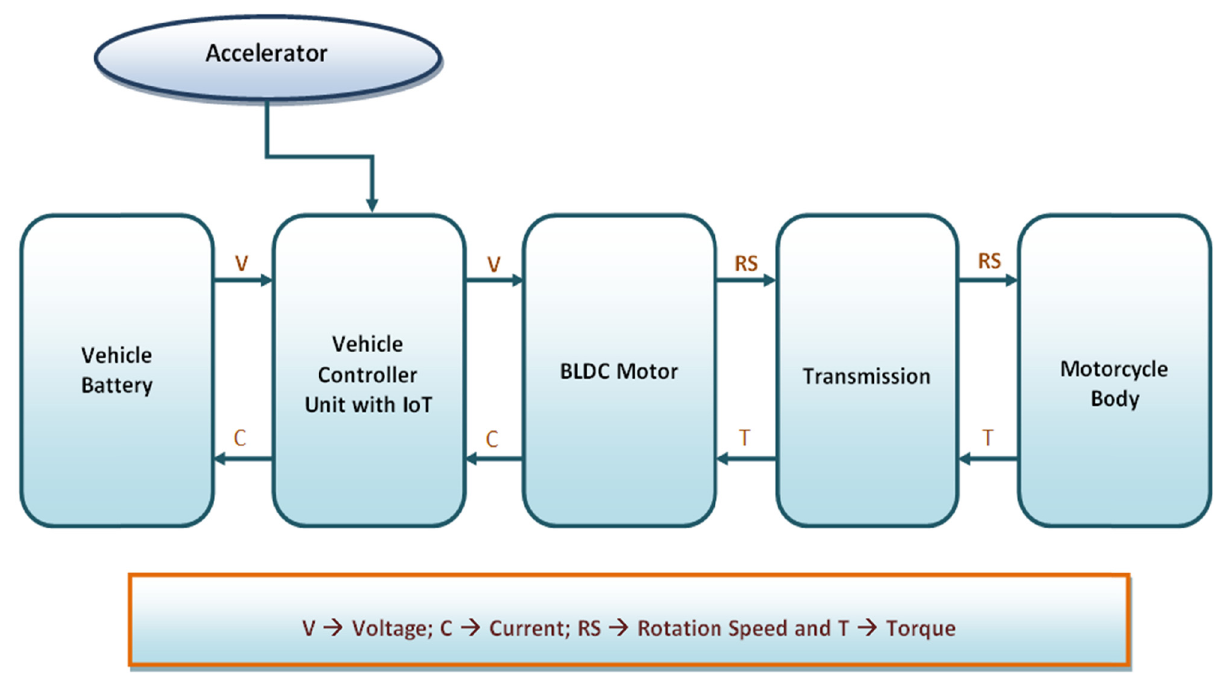
Figure 5: Signal fl ow speci fi cation of the electric